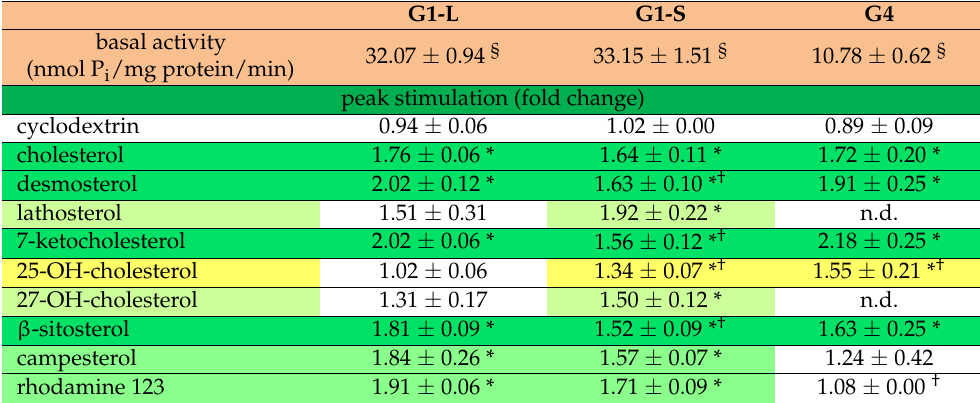
Table 1. Comparison of basal and stimulated ATPase activities of ABCG1 isoforms and ABCG4. Basal ATPase activities of the long (G1-L) and short (G1-S), as well as that of ABCG4 (G4), are shown in the second row (highlighted with orange background), whereas relative stimulations (peak ATPase activities normalised to the basal activities) are indicated in the subsequent rows (under the dark green header). G1-L G1-S G4